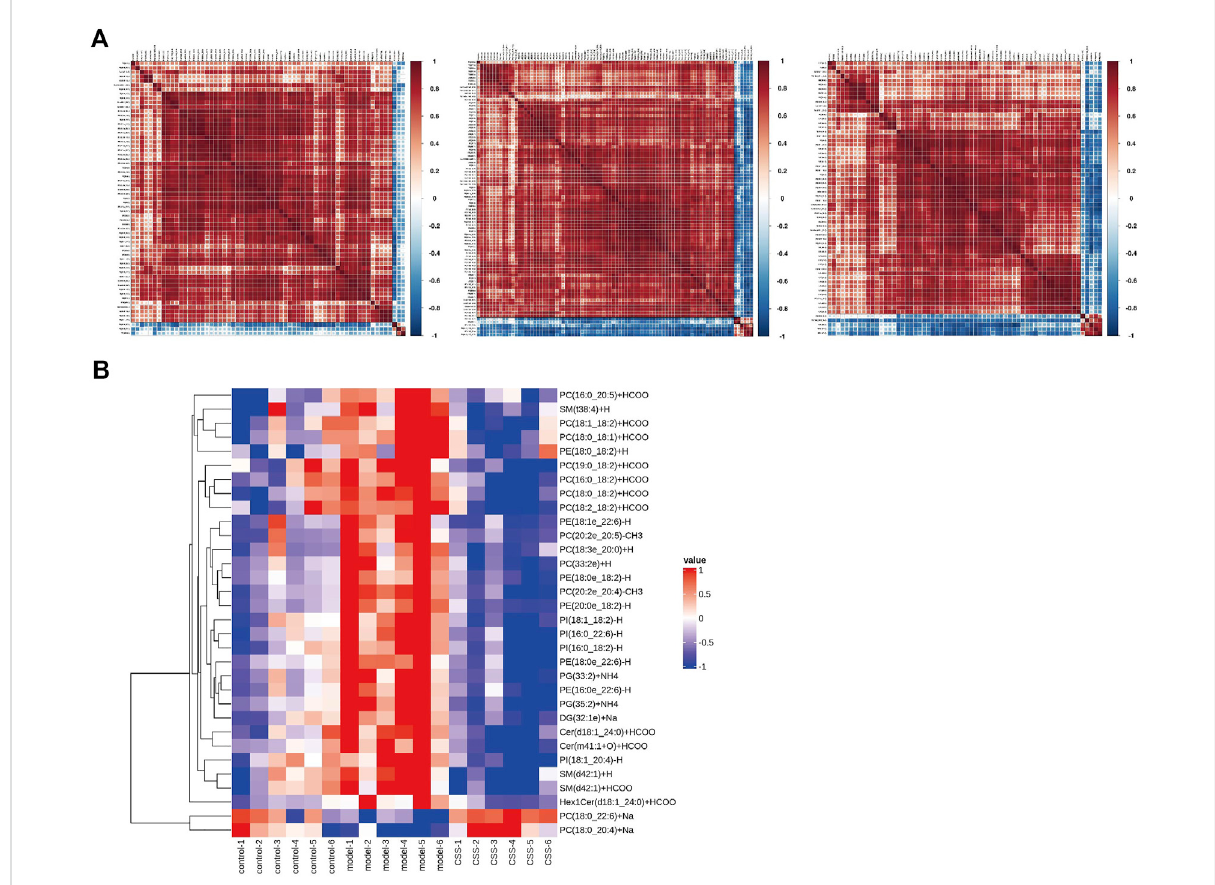
FIGURE 5 Heatmap visualization and hierarchical clustering analysis (A) and the correlation analysis results (B) based on signi fi cant difference in